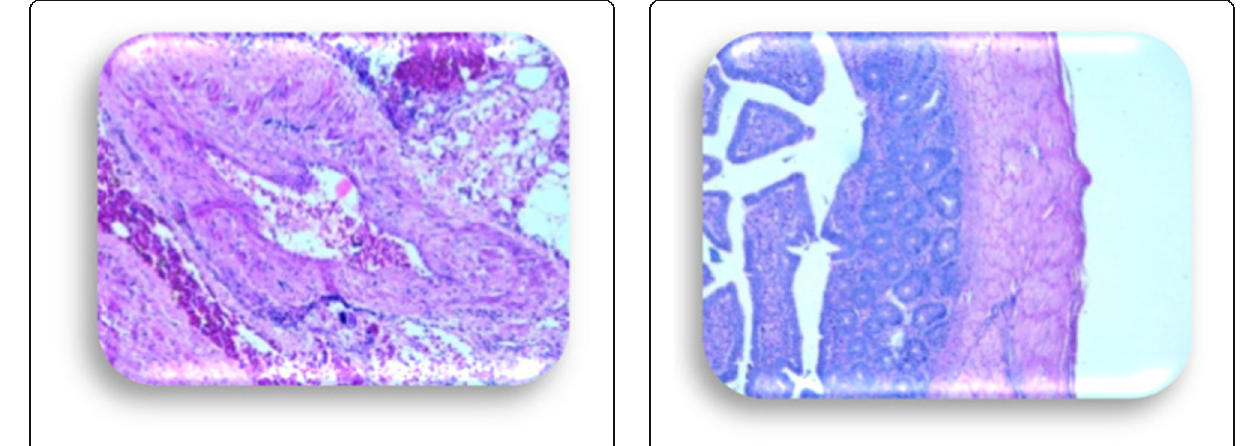
Fig. 7 kidney of chicken fed on 5% and 10% cactus peels showing congested blood vessel and thickening of the wall and perivascular